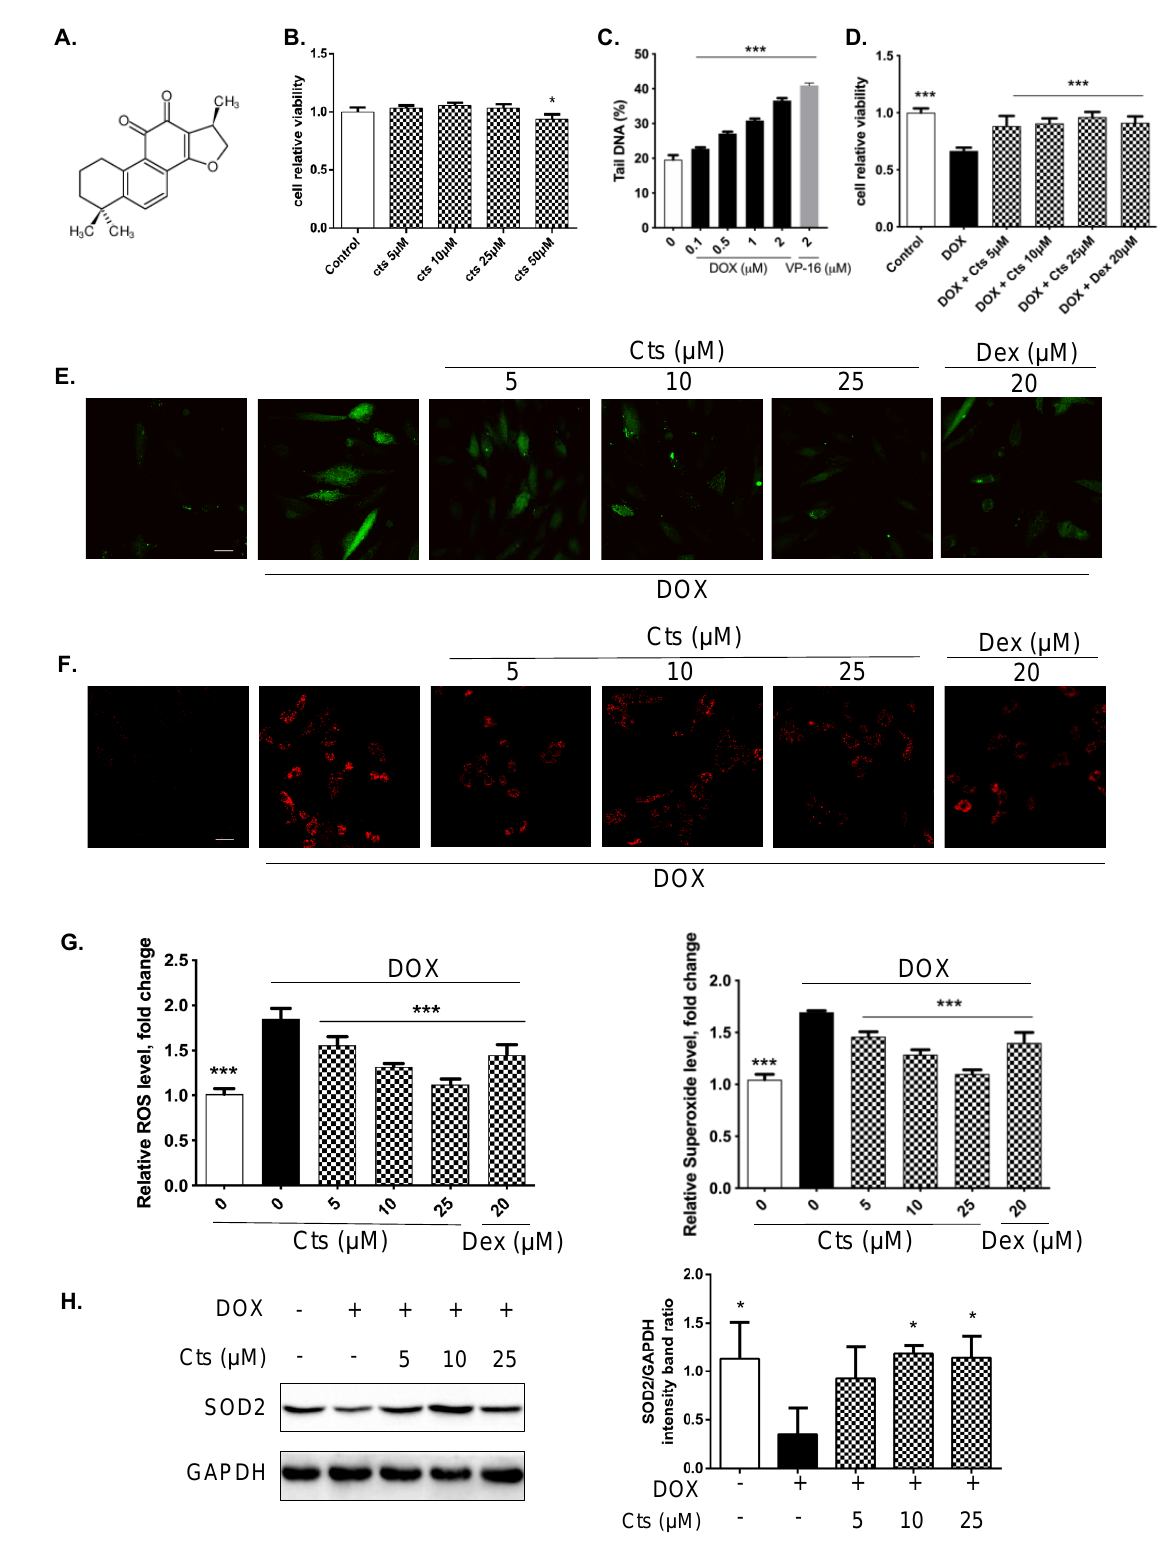
Figure 1. Effects of Cts on mitochondrial oxidative stress. ( A ) Chemical structure of Cts. ( B ) CCK-8 assay showed that Cts did not reduce cellular viability at concentrations of 5–25 µ M. Cellular viability was reduced by 6.3% at a concentration of 50 µ M. Results were presented as means ± SD ( n = 6 per group). * p < 0.05 vs. control group. ( C ) The extent of double-stranded DNA breaks induced by Dox in H9C2 cells was determined by a neutral comet assay following 24 h of treatment. Results were presented as means ± SD ( n = 6 per group). *** p < 0.001 vs. Dox-treatment group. ( D ) Dox treatment reduced cellular viability by 33.3% and Cts and Dex treatment both significantly up-regulated cellular viability. Results were presented as means ± SD ( n = 6 per group). *** p < 0.001 vs. Dox-treatment group. ( E ) Accumulation of H 2 O 2 in H9C2 cells was detected by probes DCFH2-DA and representative images showed that Dox treatment induced production